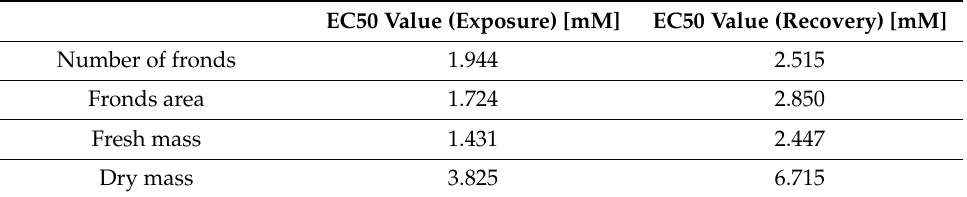
Table 1. EC50 values for morphological in Lemna minor L. exposure (subjected to tetracycline) and recovery (resumed growth after 7 days of culture in antibiotic-free